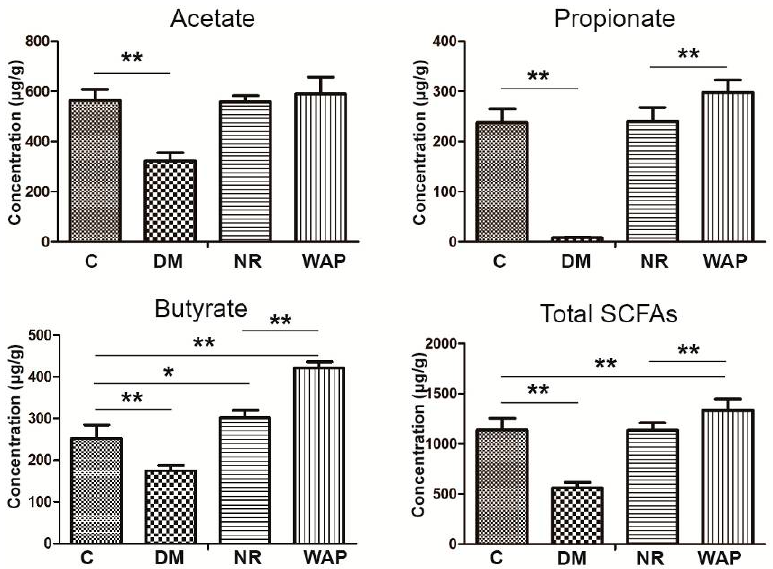
Figure 6. Effect of WAP on SFCA concentrations in fecal contents. C, control group; DM, antibiotic- associated diarrhea group; NR, natural recovery group; and WAP, Astragalus polysaccharide group. Data are expressed as means ± S.D. ( n = 6). * p < 0.05; ** p < 0.01.